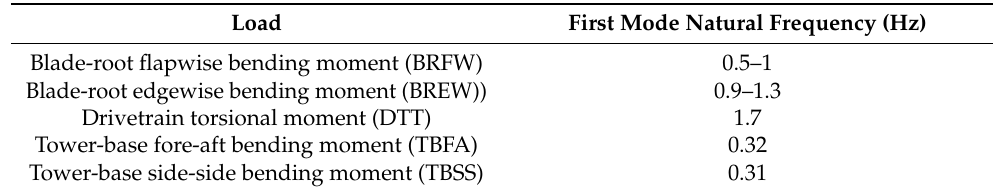
Table 5. Blade, drivetrain, and tower loads considered for analysis with respective natural frequencies.